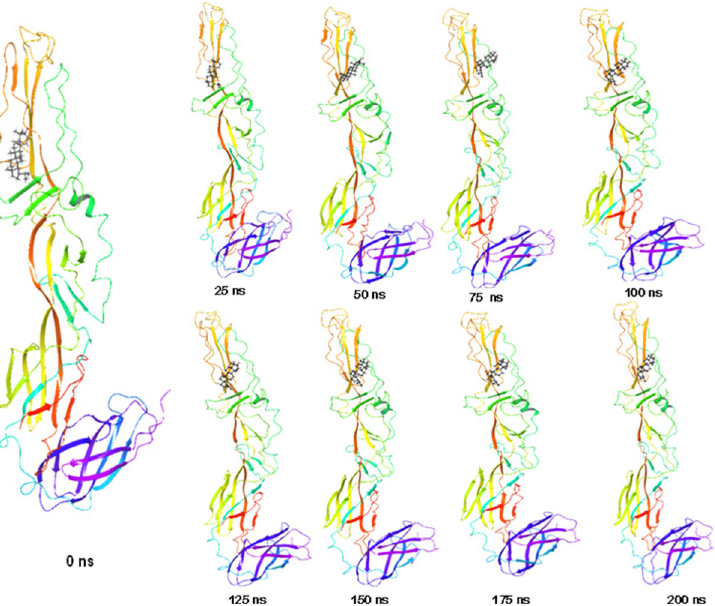
Fig 5. Stepwise trajectory analysis for every 25 ns displaying the protein and ligand conformation during 200 ns of simulation. https://doi.org/10.1371/journal.pone.0263853.g005 The stepwise trajectory analysis of every 25 ns of simulation of Lupenone with 2ALA tyro- sine kinase displayed the positional alteration with reference to 0 ns structure (Fig 5). It has been observed that the ligand, Lupenone have possessed a structural angular movement at the end frame to achieve its conformational stability and convergence.